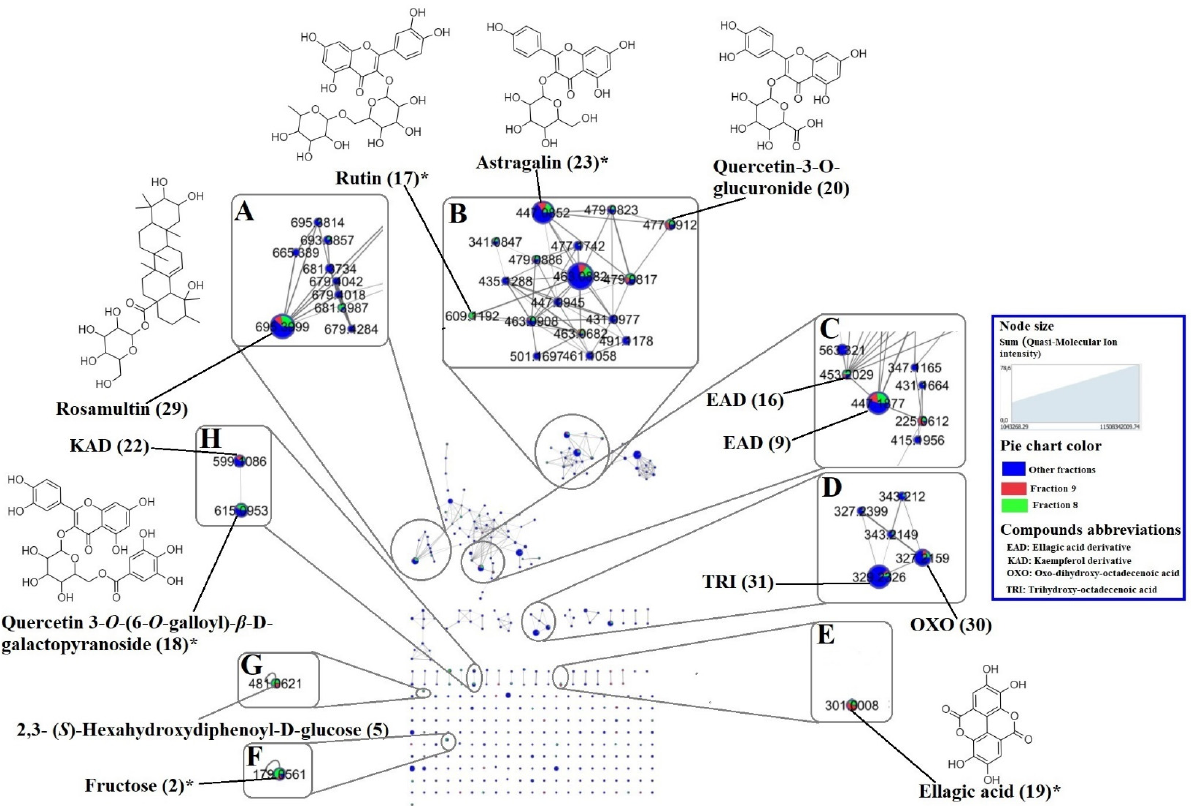
Figure 1. Molecular network of fractions 1 to 9 of Terminalia leiocarpa leaves MeOH extract showing the major compounds in fractions 8 (green), 9 (red), and other fractions (blue). The numbers indicate the identification code of the compounds and asterisks show the compounds whose identification was confirmed by injection with the standard. ( A ) triterpenic derivatives, ( B ) O -glycosylated flavonoids, ( C ) ellagic acid derivatives, ( D ) fatty acids, ( E ) ellagic acid, ( F ) sugar, ( G ) tannin, ( H ) glycosylated galloylated flavonoids. Edge widths are proportional to the level of similarity (cosine score). The size of the nodes is proportional to the sum of quasi-molecular ion intensity of fractions 1 to 9. * compounds identified by standard